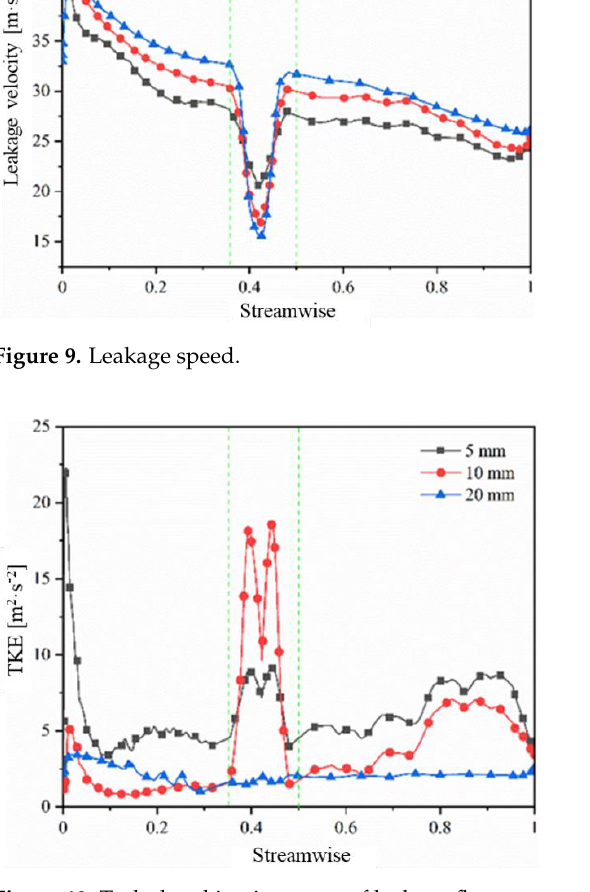
Figure 10. Turbulent kinetic energy of leakage flow.